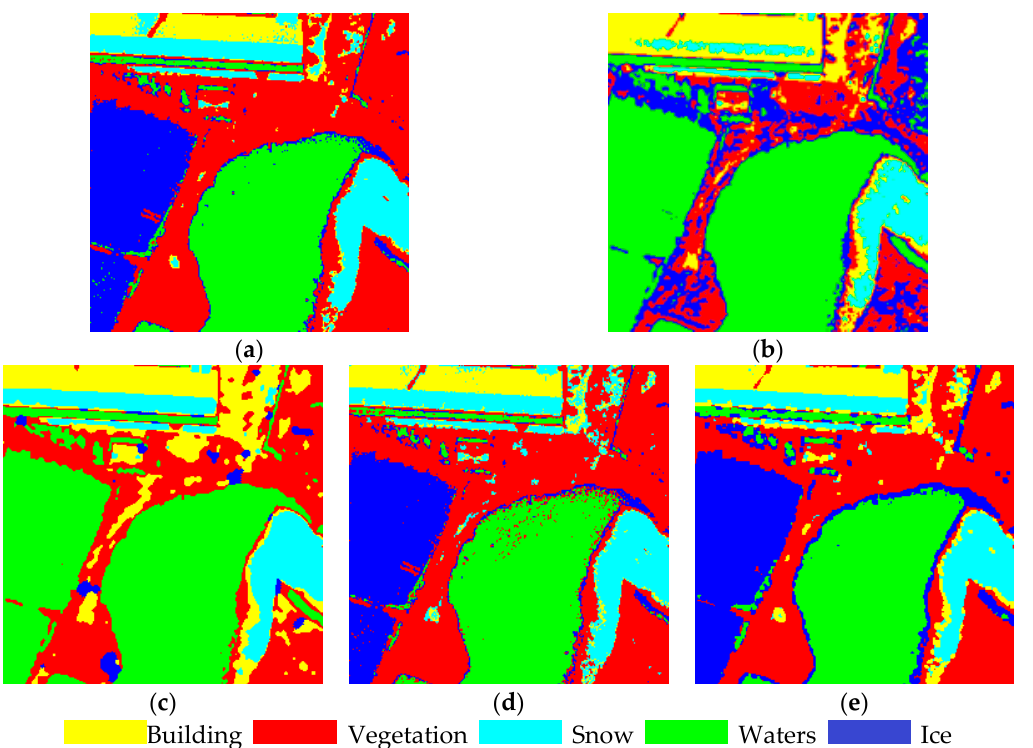
Figure 12. Word View-2 image classification results. ( a ) Maximum likelihood method; ( b ) FCM; ( c ) HMRF-FCM; ( d ) Weighted average method; and, ( e ) Neighborhood weighted average.